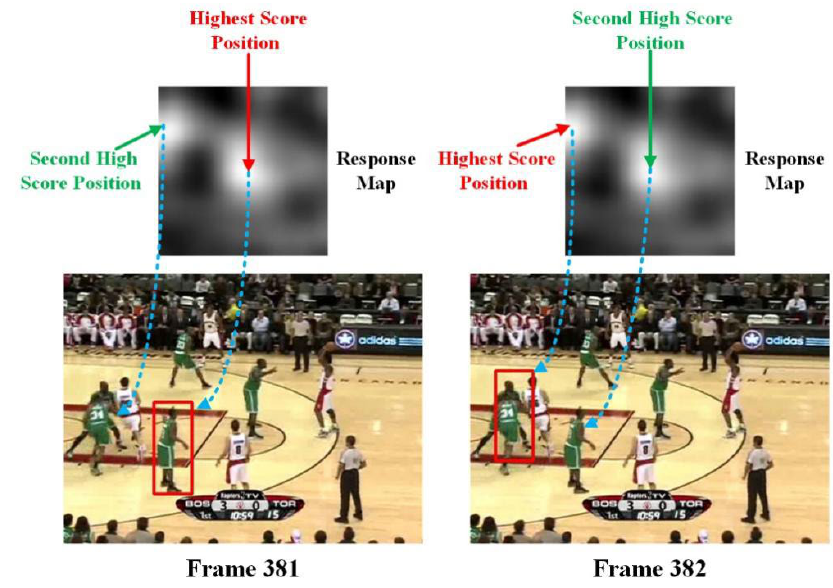
Figure 2. Tracking drift from frame 381 to frame 382.